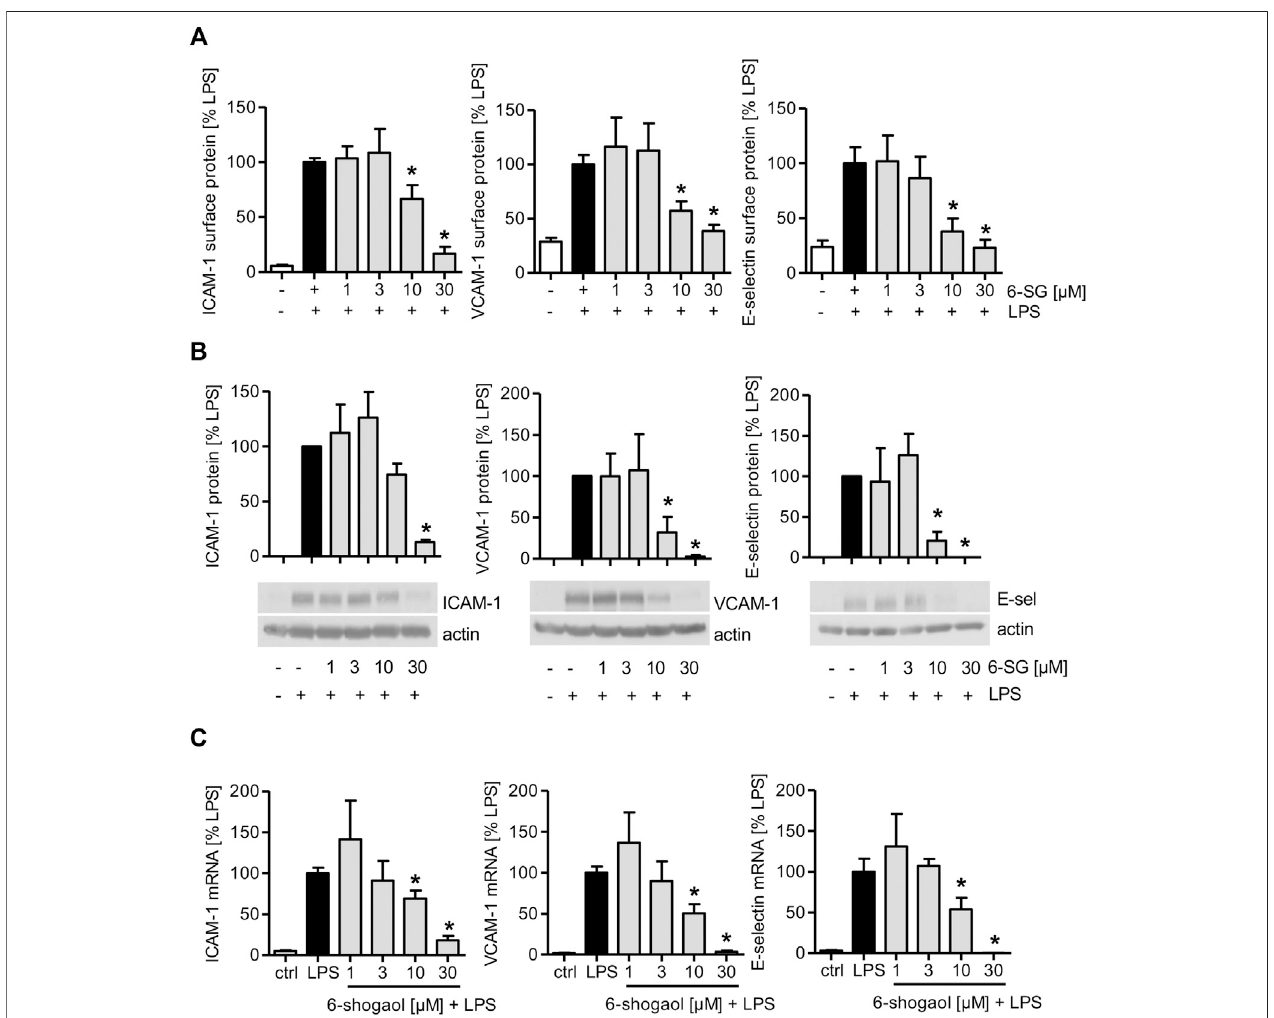
FIGURE 2 | LPS-induced CAM levels in HUVECs are downregulated by 6-shogaol in a concentration-dependent manner. Con fl uent HUVECs were treated with indicated concentrations of 6-shogaol. After 30 min, the cells were activated by LPS (1 μ g/ml) for (A,B) 4 h (E-selectin) or 24 h (ICAM-1 and VCAM-1) to determine protein levels and for (C) 2 h (E-selectin) or 12 h (ICAM-1 and VCAM-1) for mRNA expression. (A) Surface protein levels of ICAM-1, VCAM-1, and E-selectin were determinedby fl owcytometry,and (B) total protein levelsofCAMswere analyzed byWestern blotanalysis.Actin served astheloadingcontrol.Onerepresentative blotisshown. (C) mRNAdatawereobtainedbyqPCR.GAPDHservedasthehousekeepinggene.6-SG:6-shogaol. Dataareexpressed asmean±SD; (A,C) n =3; (B) n = 4/4/3; * p ≤ 0.05 vs.